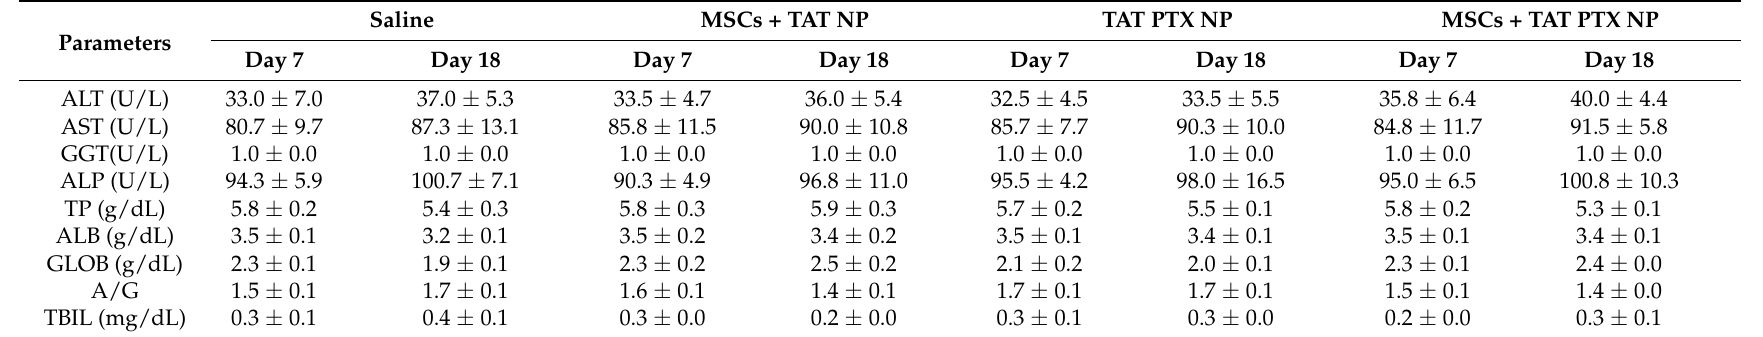
Table 1. Effect of different treatments on liver function test. Data represents mean ± SD ( n = 4).